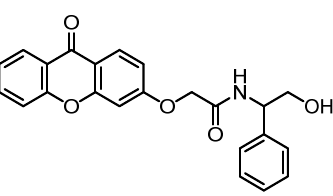
Figure 5. Chemical structure of xanthone derivative XD-10.